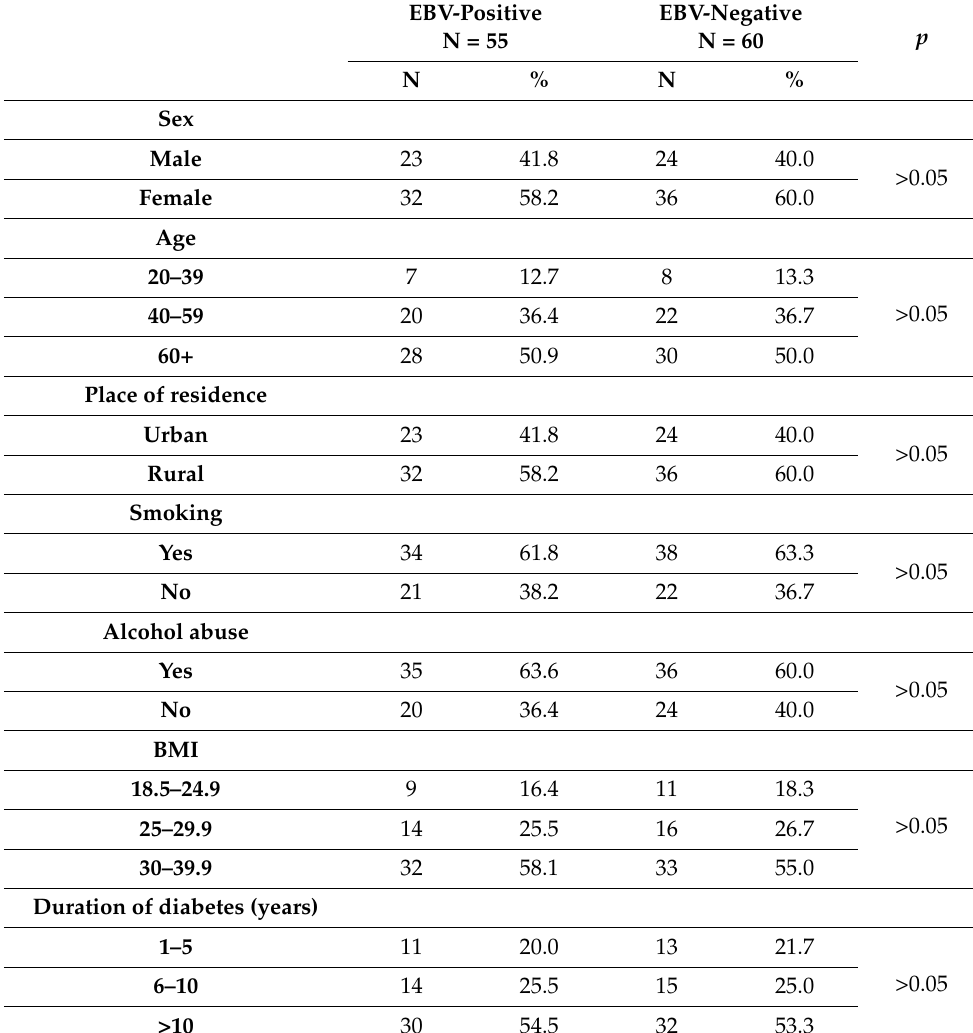
Table 1. Epidemiological characteristics of EBV-positive and EBV-negative diabetic